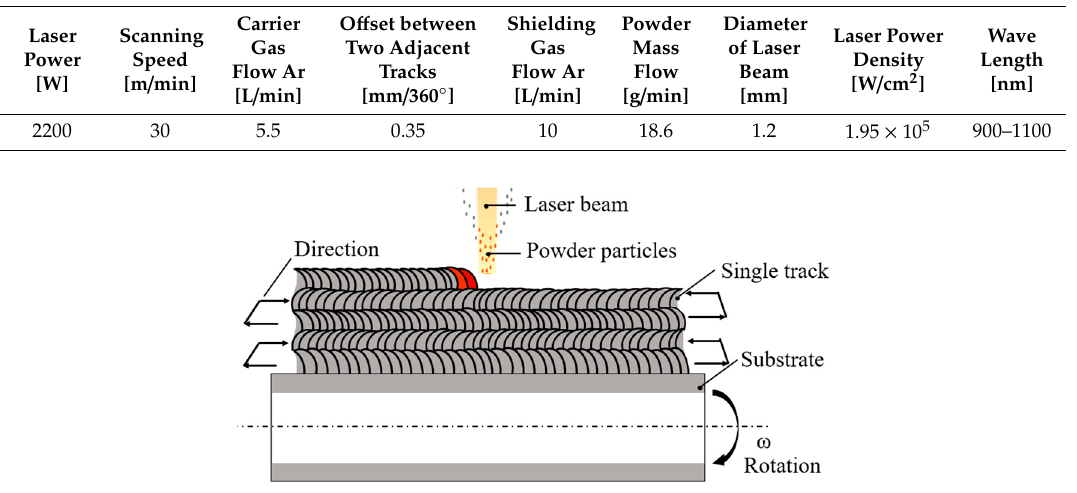
Table 2. The surface of the substrate was sandblasted and cleaned with alcohol before being processed with EHLA. Table 2. Chemical composition of the E355 substrate material (in wt